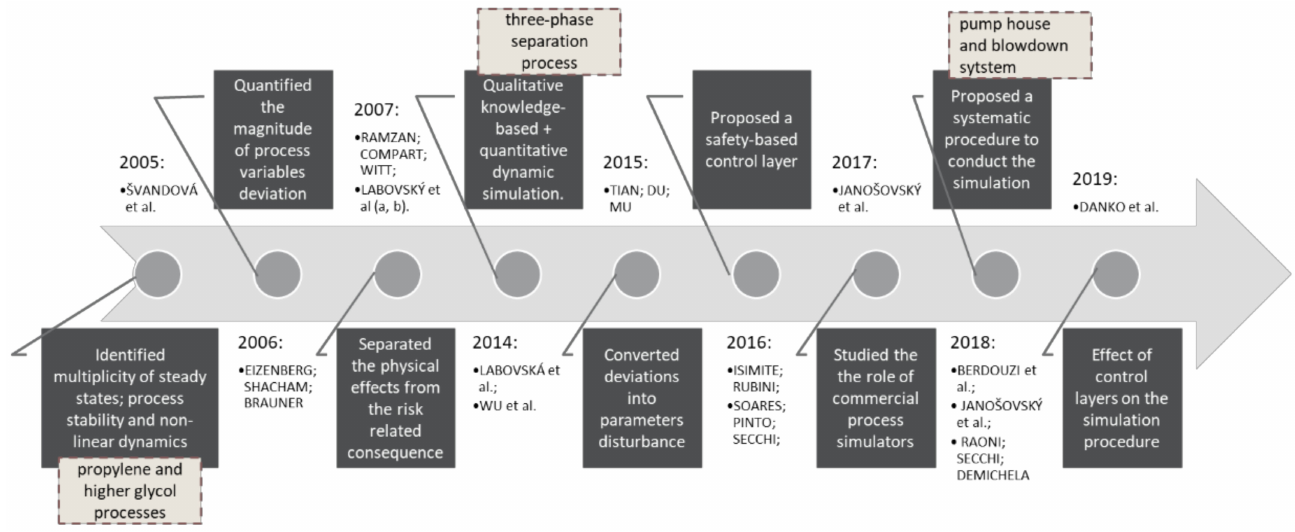
Figure 1. Works in the chemical engineering area employing modeling and simulation-based hazard identification